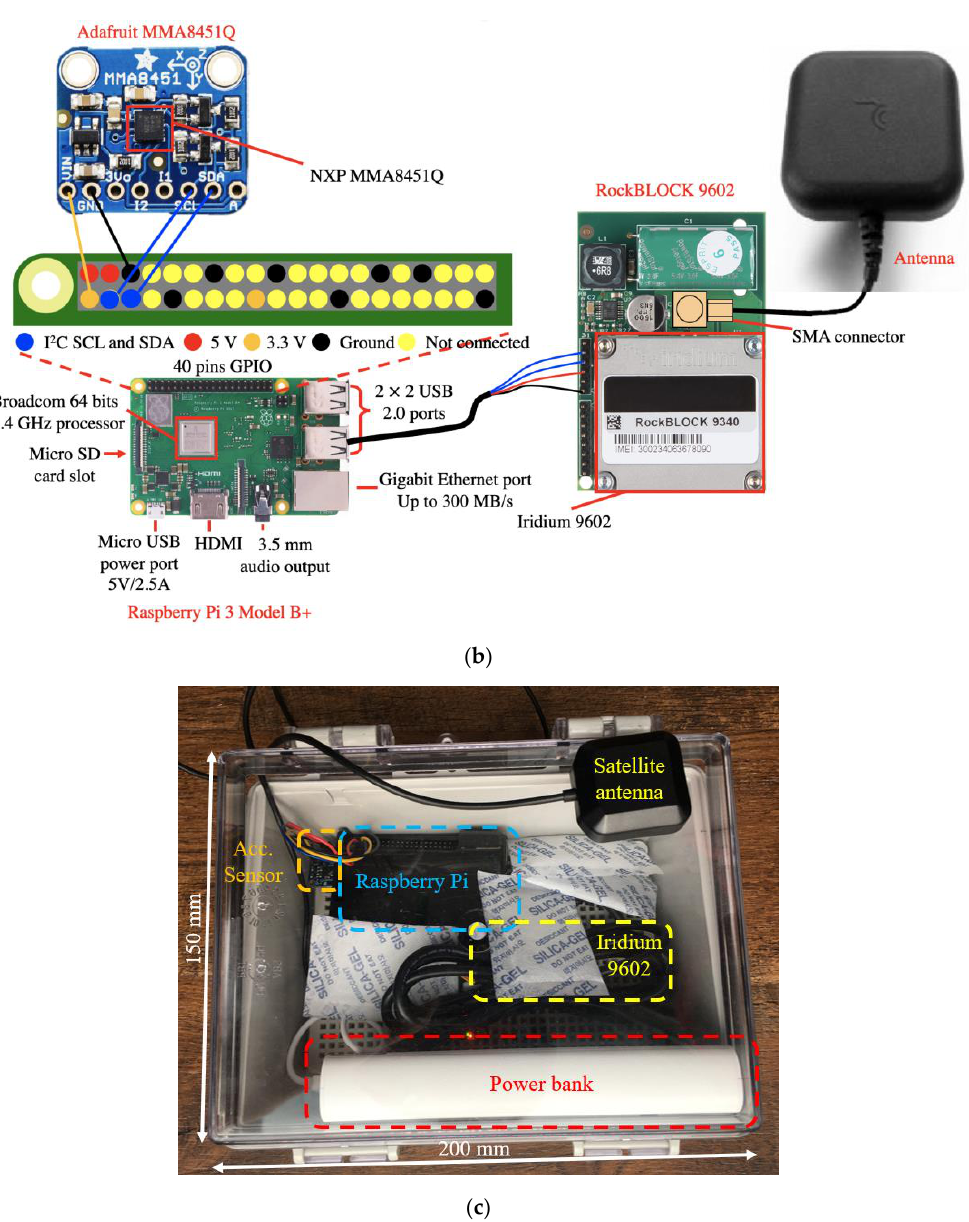
Figure 1. Hardware architecture: ( a ) Hardware design for sensing interface, computational core, Figure1. Hardwarearchitecture: ( a )Hardwaredesignforsensinginterface, computationalcore, wireless wireless communication, and power supply; ( b ) hardware connection with key components communication, and power supply; ( b ) hardware connection with key components highlighted; and ( c ) highlighted; and ( c ) assembled satellite-based sensing package for in-site surface wave testing. assembled satellite-based sensing package for in-site surface wave